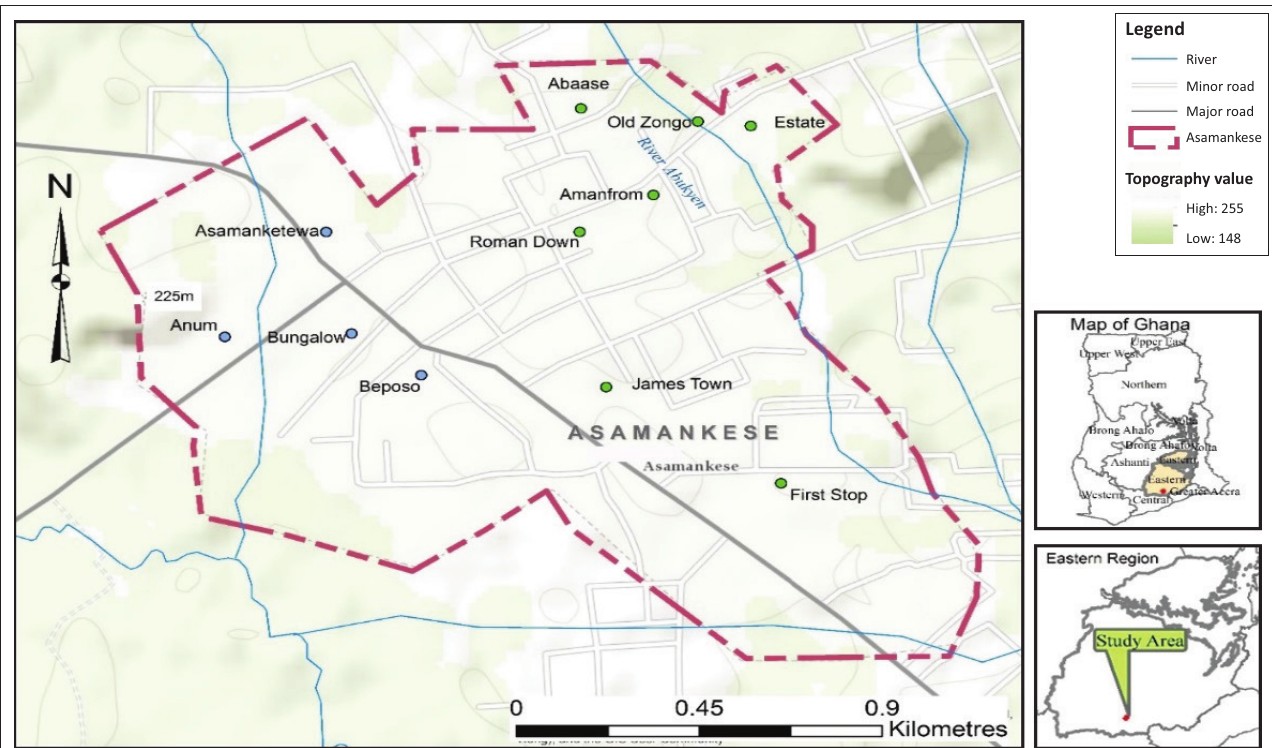
FIGURE 1: Map of Asamankese